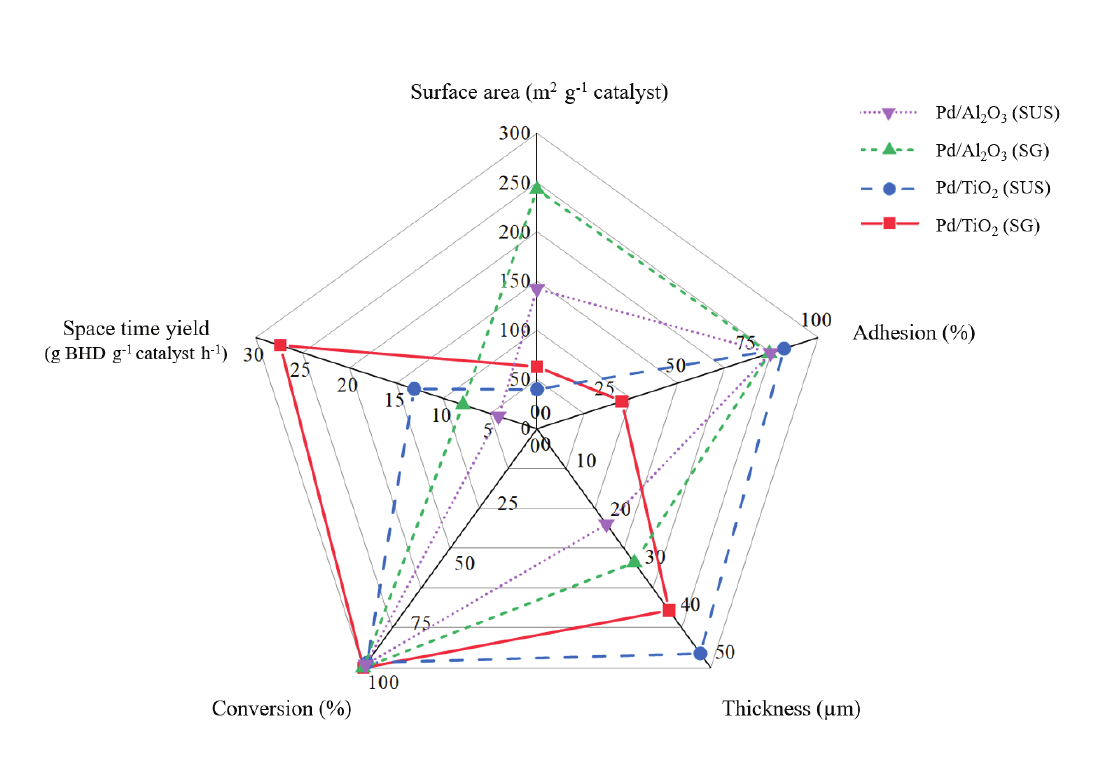
O (SG), Pd/TiO 2 3